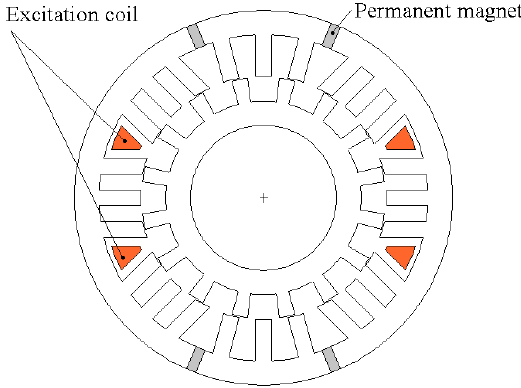
Figure 3. Doubly salient hybrid excited structure (inner rotor) [46].